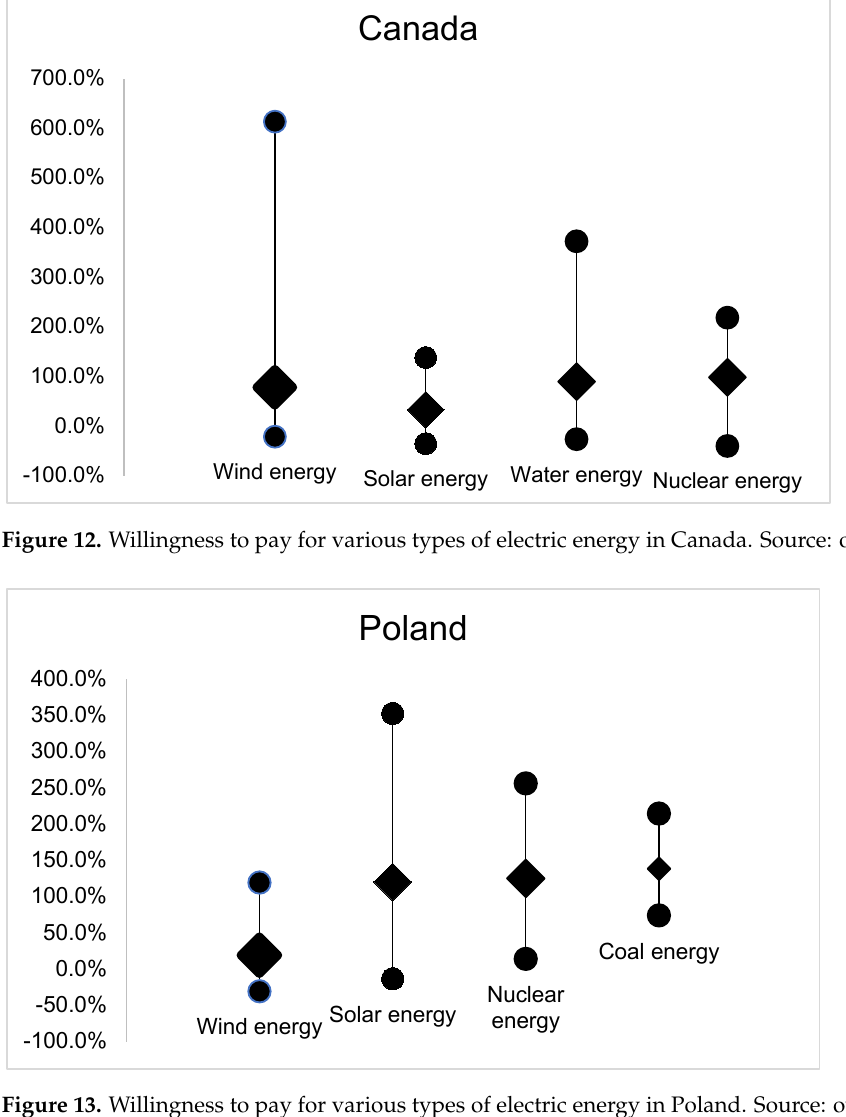
Figure 13. Willingness to pay for various types of electric energy in Poland . Source: own study.